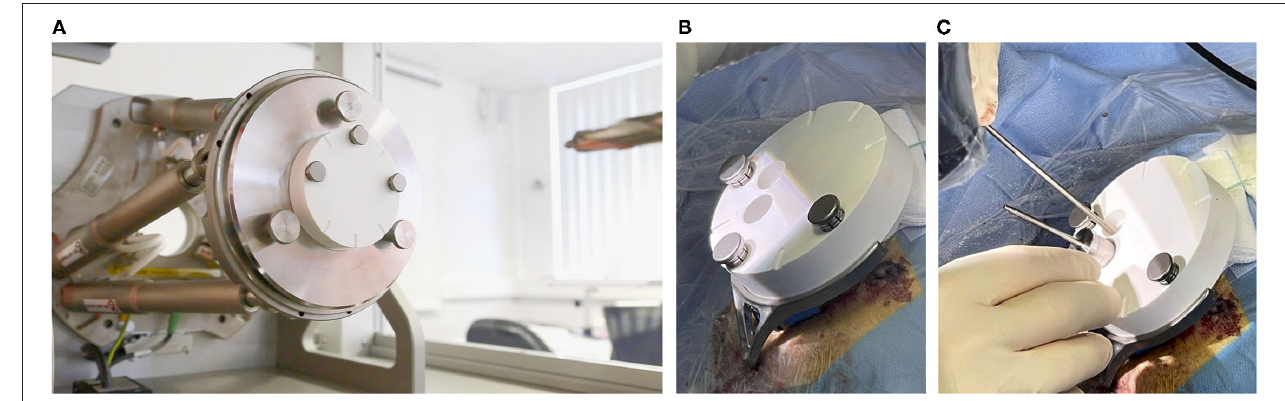
FIGURE 6 | (A) The (white) blank jig inside of the automated manufacturing machine, and (B) mounted on the frame. (C) A tool guide is put into the main through-hole and the sham drill bit can be inserted into the tool guide. The second through-hole can be used to inspect the path inside the conventionally opened area.